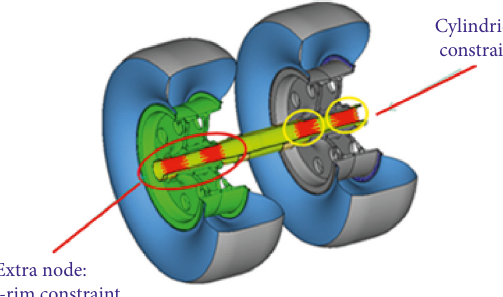
Figure 14: Modelling of the joints between wheels and